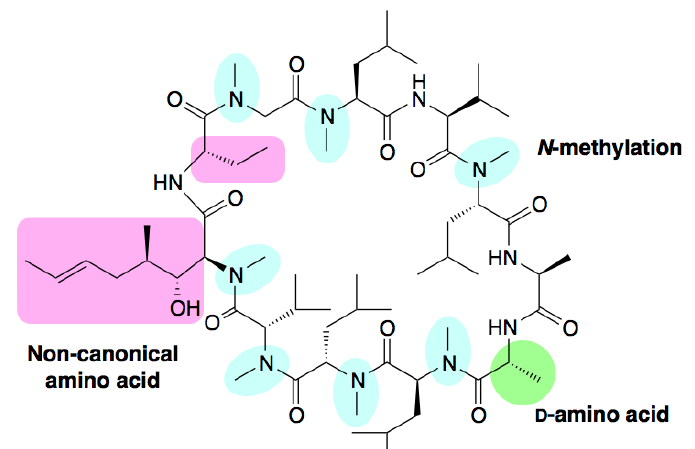
Figure 1. Structural characteristics of cyclosporine A. Cyclosporin A is an 11 residue N-C macrocyclic peptide. Seven peptide bonds are N- methylated (highlighted in blue). Two residues possess non-proteinogenic sidechains (highlighted in pink) and a single D -alanine is present (highlighted in green)